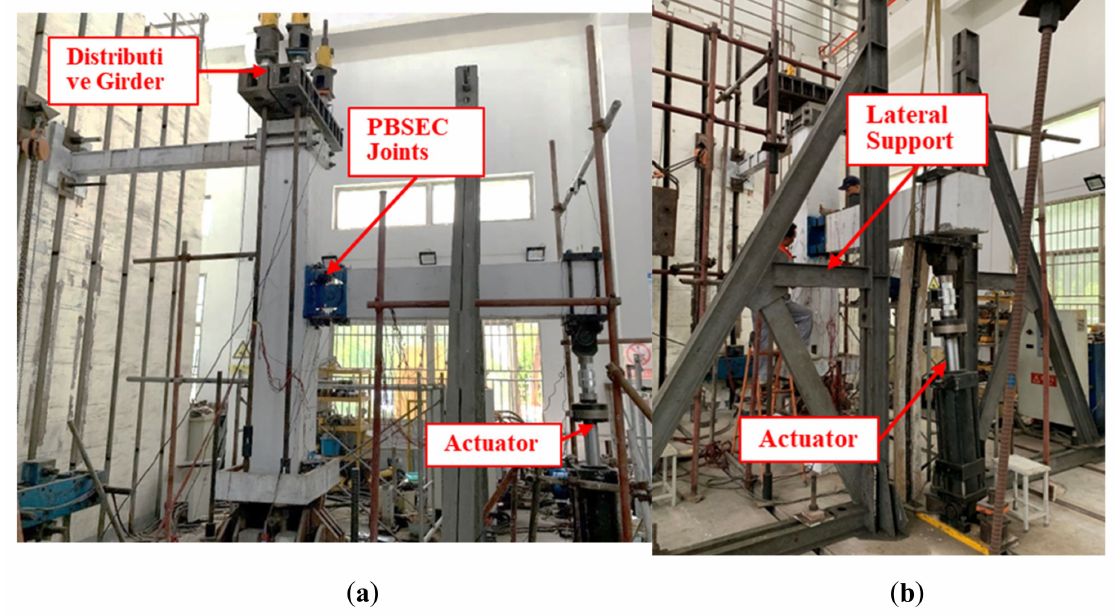
Figure 7. Photograph view: ( a ) Front view; ( b ) Side